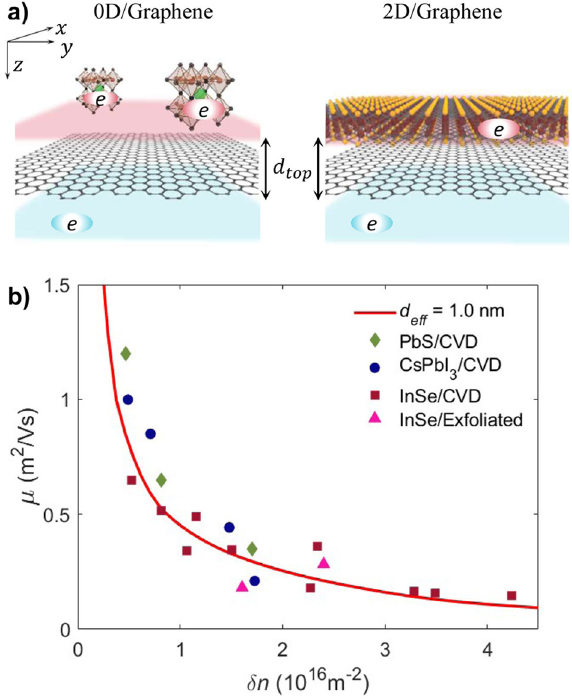
Fig. 4 Mobility characteristics of graphene devices and heterostructures. a Schematic diagram showing the position of impurities and surface- charges, due to 0D structures (e.g., perovskites) and 2D structures (e.g., InSe), with respect to the graphene sheet. b Relationship between mobility, μ , and the full width at half maximum (FWHM), δ n , obtained using the Discontinuous Galerkin (DG) simulations, taking d eff = 1.0 nm. In surface- decorated devices, the effective impurity distance, d eff , describes combined effect of charges below ( d imp ) and above ( d top ) graphene layer compared to data from multiple modi fi ed graphene samples (data points for each sample type are labelled as shown in the inset